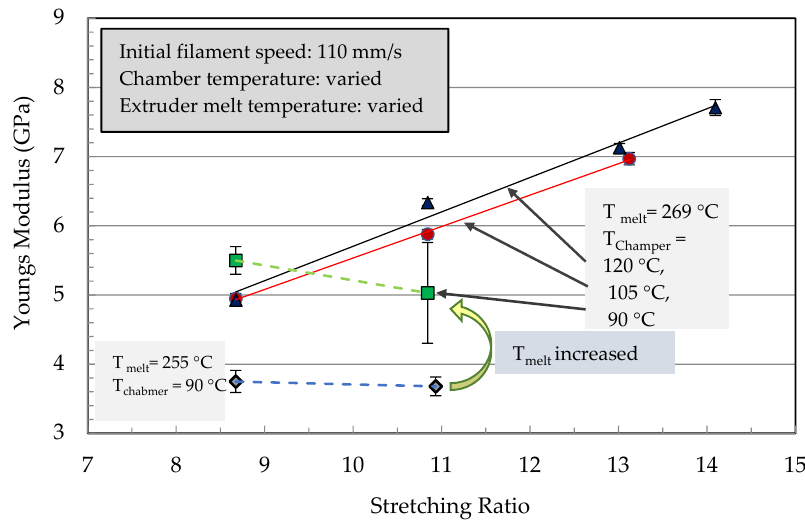
Figure 7. Young’s modulus of the stretched PP/22 wt% PET filaments as a function of the stretching ratio for different processing temperatures of the extruder (melt temperature) and the stretching chamber.